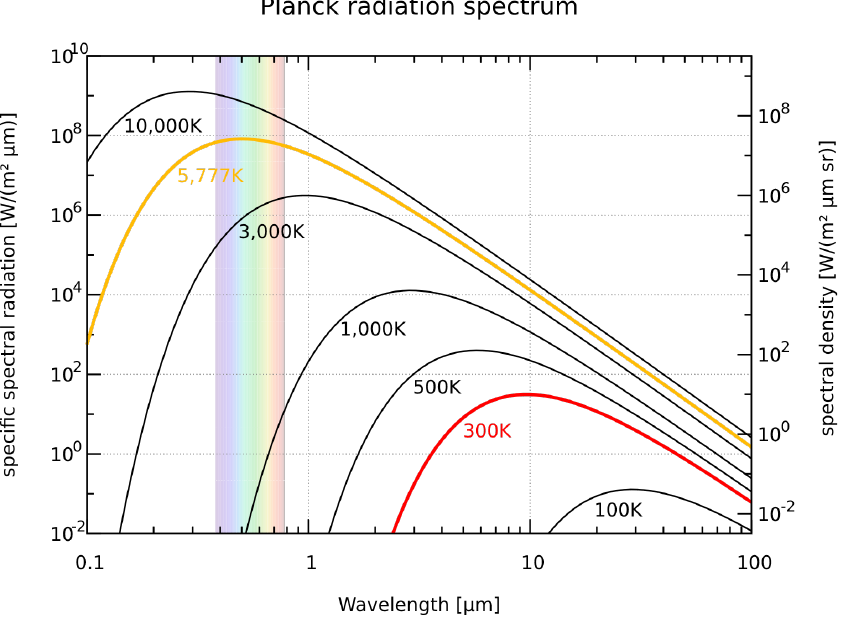
Figure 3. Black–body spectrum for different temperatures. Temperature of the Sun is marked in yellow, and typical ambient temperature is marked in red